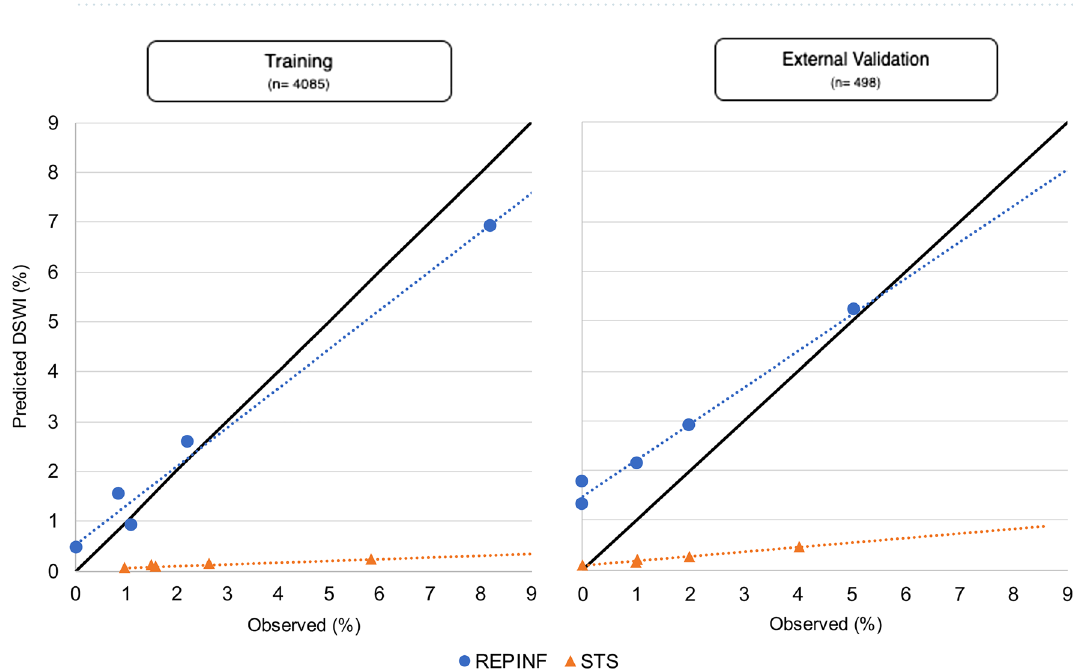
Figure 2. Calibration in-the-large plot on training and external validation. REPINF, Sao Paulo, Brazil,